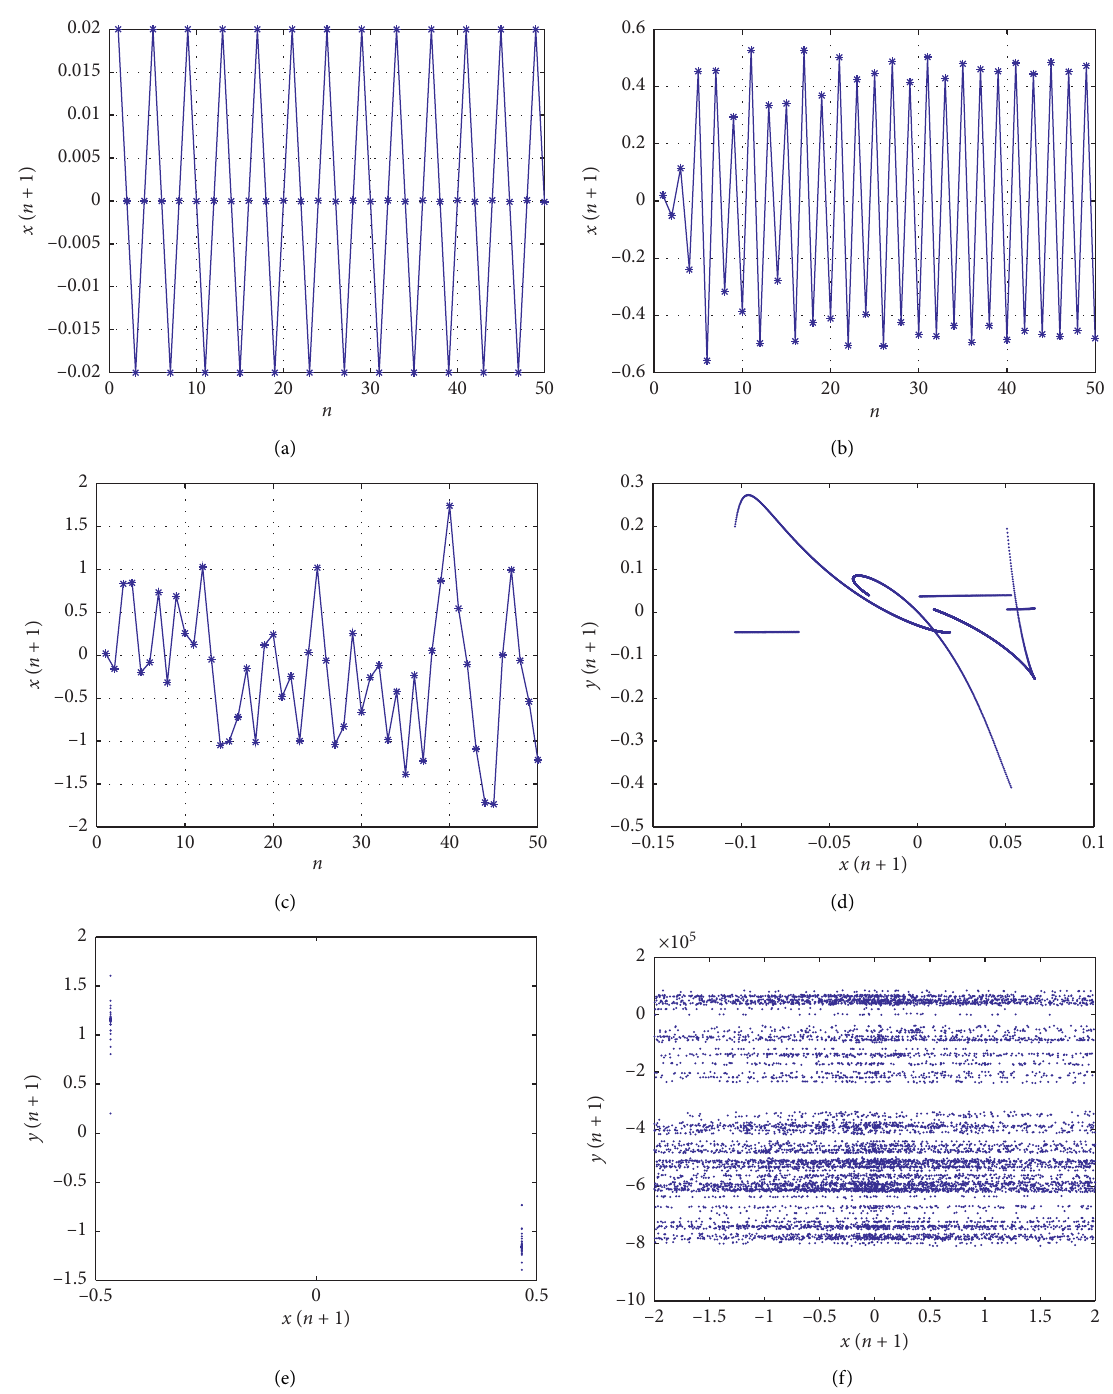
Figure 6: Iteration and trajectory analyses of the second proposed chaotic map at x r � 4.6, and (c) r � 10.0. Trajectory property at (d) r � 3.0, (e) r � 4.6, and (f) r �